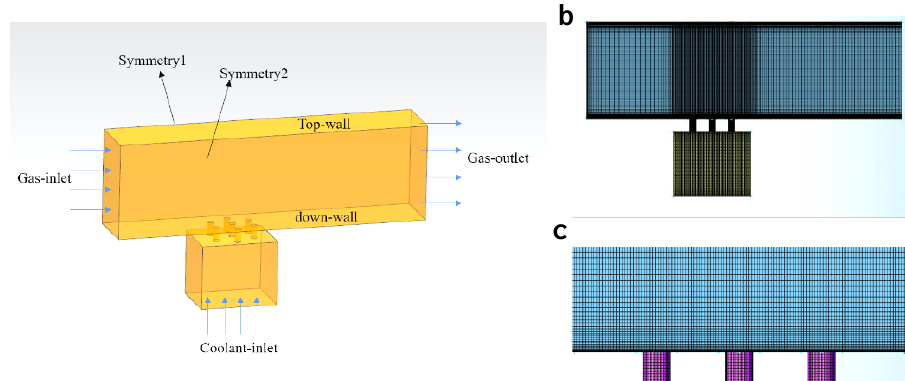
Figure 2. ( a ) Schematic of the simulation model and the boundary conditions. The detail of the generated mesh from the side view ( b ) and in the near wall region ( c